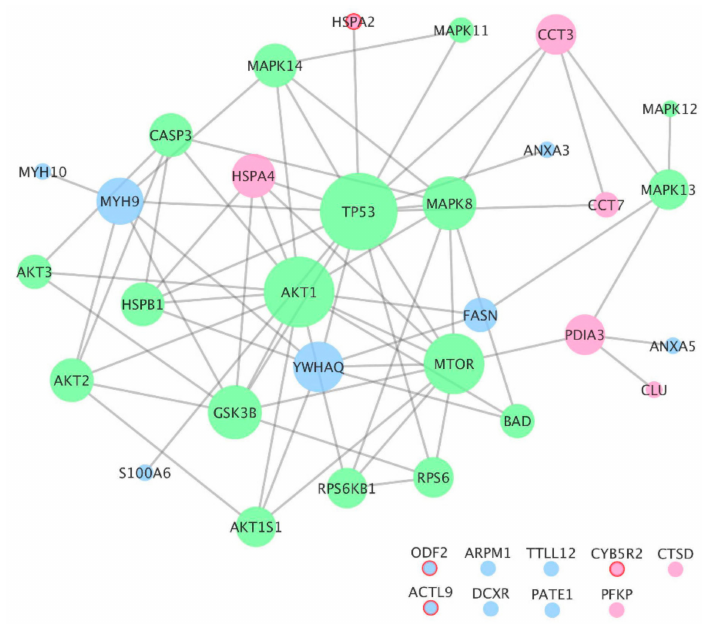
Figure 2. Network of the sperm proteins di ff erentially associated with male age. Green nodes represent the proteins identified in this study whose activity is correlated with age. Pink and blue nodes represent the proteins gathered from the literature search that are upregulated or downregulated in older men, respectively. Red outline represents testis-enriched / specific proteins. Node sizes represent the relative degree of the